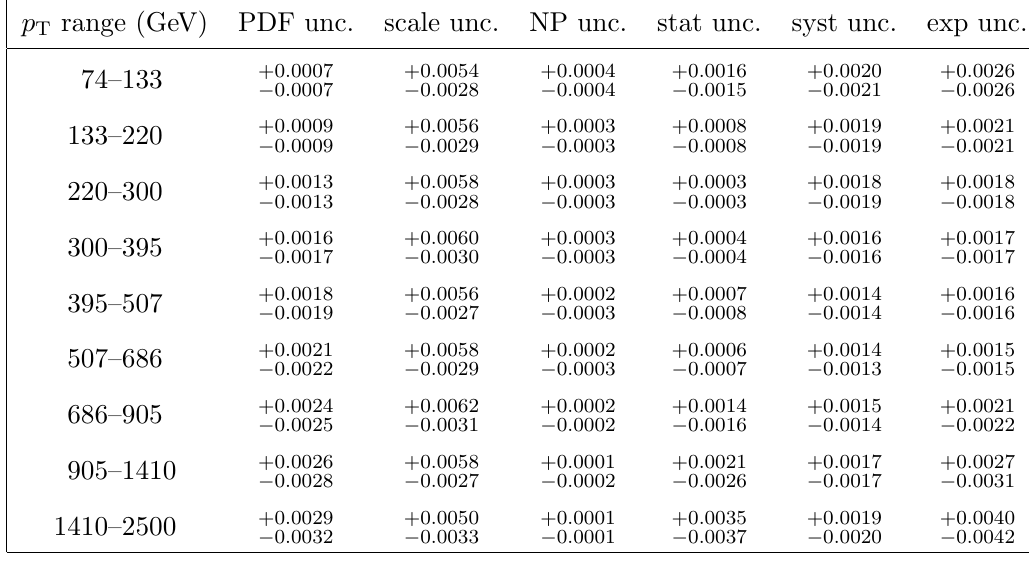
Table 6 . Composition of the uncertainty in (cid:11) S ( M Z ) (cid:12)t results in ranges of p T . For each range, the corresponding statistical and experimental systematic uncertainties and the components of the theoretical uncertainty are shown. The numbers are obtained by using the CT10 NLO PDF